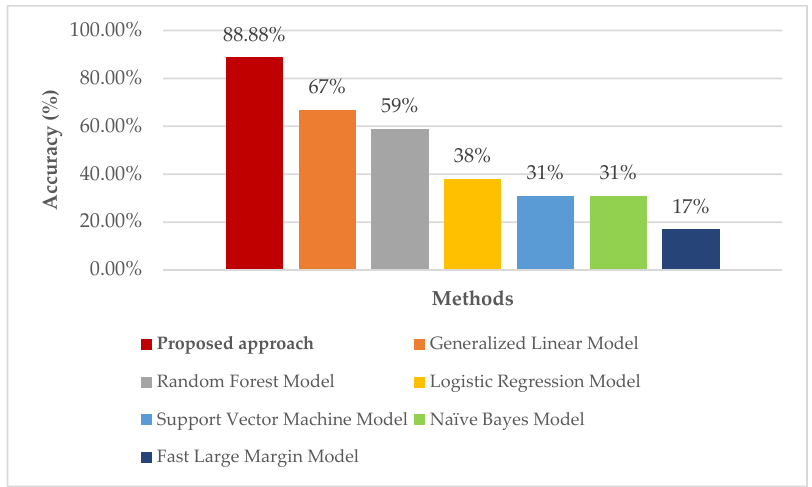
Figure 5. The comparison of the proposed approach comparison with other models; its prediction is more precise.